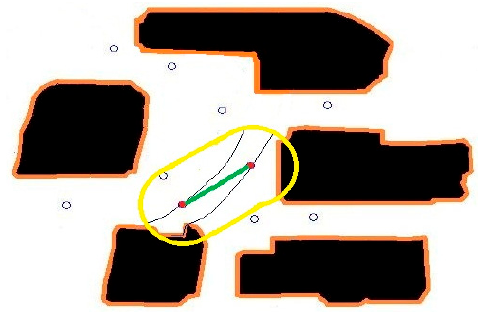
Figure 14. The map of particle paths using two sensors.